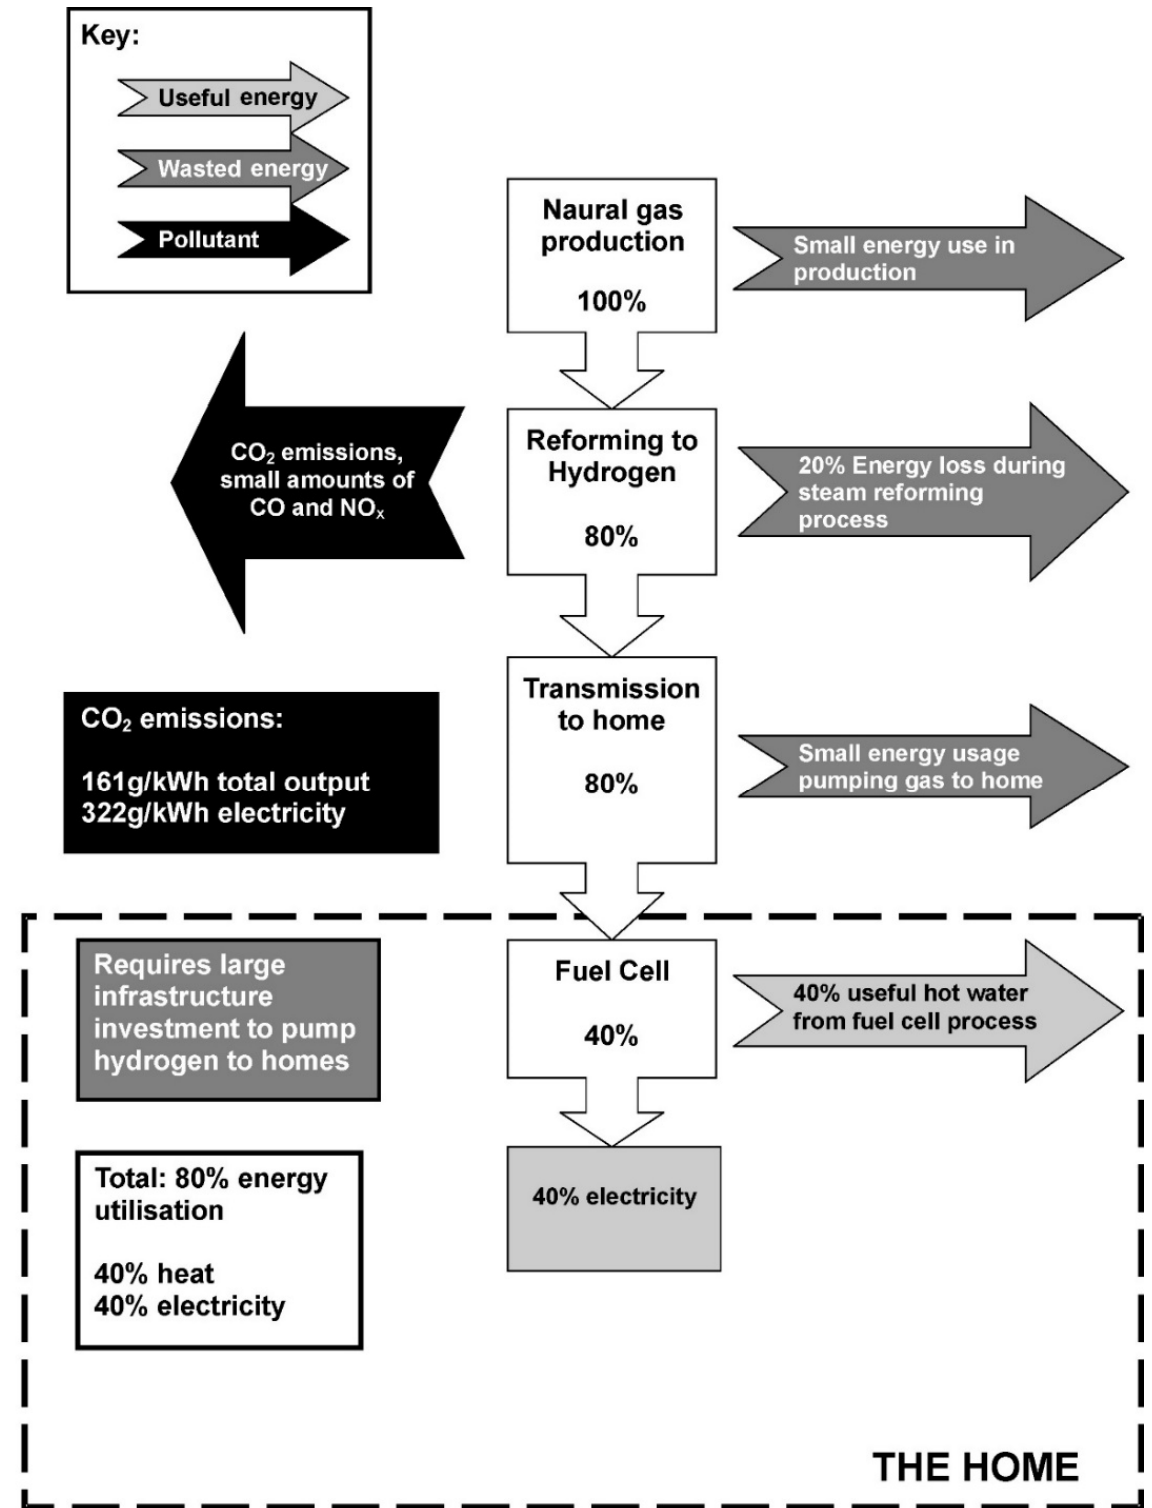
Figure 10. Indicative energy and emissions balances for a micro-CHP system based on a fuel cell (FC) with off-site industrial hydrogen reformer on a ‘full fuel cycle’ basis.